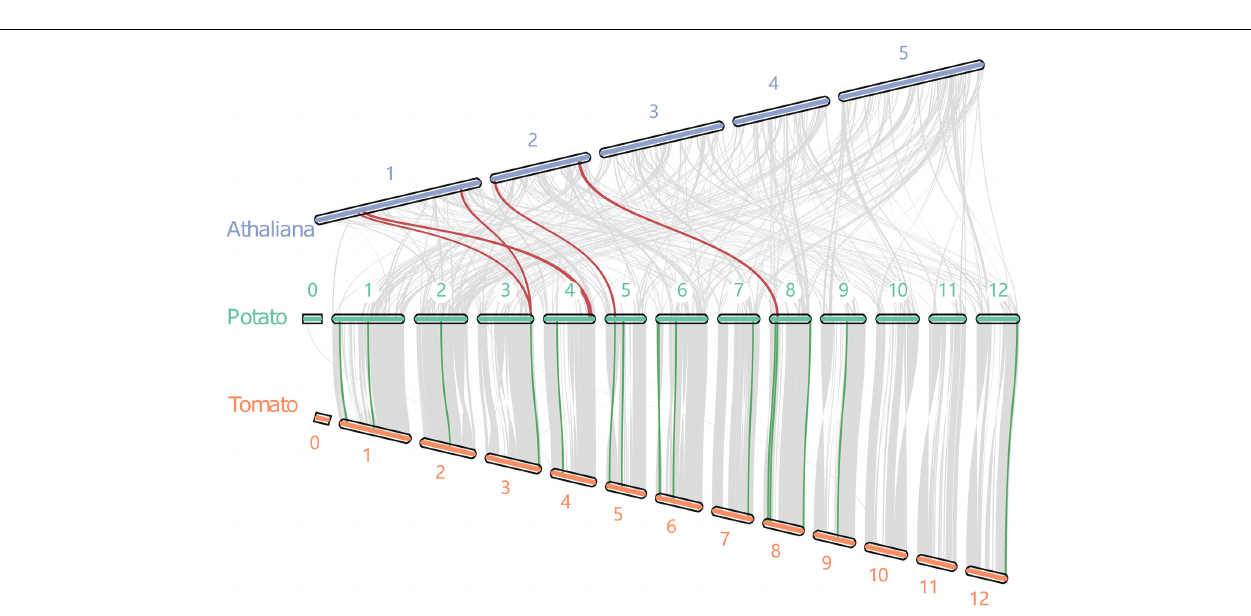
FIGURE 3 | The collinear relationship between potato, tomato and Arabidopsis . Red and blue lines indicate the collinear gene pairs of potato and Arabidopsis , and potato and tomato, respectively.